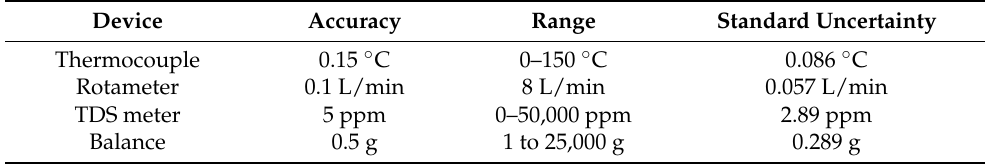
Table 4. Specifications of the measuring devices and values of uncertainty.